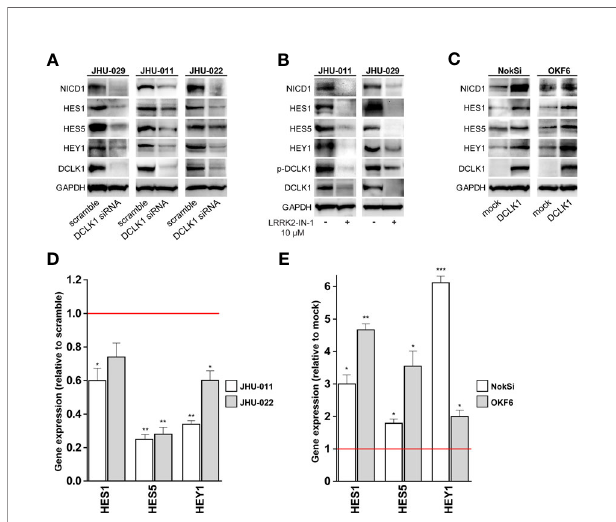
FIGURE 5 | DCLK1 in fl uences NOTCH signaling in vitro . (A) DCLK1 expression was knocked down in three indicated HNSCC cell lines using siRNA. Cell transfected with scramble non-targeting siRNA were used as controls. Whole cell lysates were prepared from DCLK1-depleted and control cells and analyzed western blot for the expression of indicated proteins. (B) Two HNSCC cell lines were treated with either LRRK2-IN-1 or DMSO (solvent) for 72 hours. Cell lysates were collected at end point and analyzed by western blot for the expression of indicated proteins. GAPDH was used a loading control. (C) Forced expression of DCLK1 in two normal human oral keratinocytes cell lines expressing low level of endogenous DCLK1. Cell lysates were collected from DCLK1-expressing cells and control cells infected with empty vector and analyzed by western blot for the expression of indicated proteins. GAPDH was used a loading control. (D) RT-PCR results of NOTCH target genes in DCLK1-depleted HNSCC cells, demonstrating signi fi cant reduction relative to the control cells (red line). (E) RT-PCR results of NOTCH target genes in DCLK1 overexpressing normal human oral keratinocytes cell lines, demonstrating signi fi cant elevation relative to the control cells (red line). (*p < 0.05, **p < 0.01 and ***p <